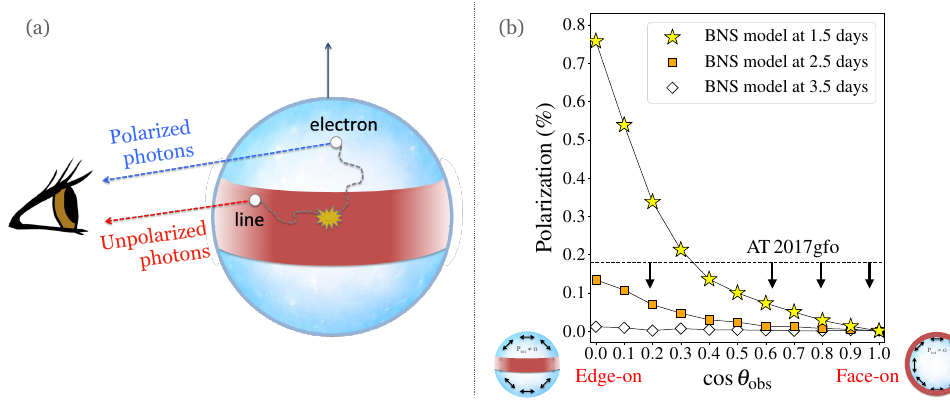
Figure 3. Polarized light from KNe. ( a ) Sketch illustrating the origin of polarization in KNe. Photons escaping from lanthanide-rich dynamical ejecta around the equatorial plane (in red) are preferentially depolarized by bound–bound line interactions; photons escaping from a lanthanide-free wind (in blue) can be linearly polarized by Thomson scattering. Figure adapted with permission from [155]. Copyright 2018 Bulla. ( b ) Polarization predictions from [154] for a two-component BNS model. Polarization levels are shown at 7000 Å as a function of viewing angle θ obs for three different epochs: 1.5 (yellow stars), 2.5 (orange squares) and 3.5 (white diamonds) days from the merger. The V − band polarization upper limit derived for AT2017gfo at 1.5days is shown with a horizontal dashed line and is consistent with an observer viewing the system from an angle within θ obs ∼ 70 ◦ from the jet axis (cos θ obs (cid:38)